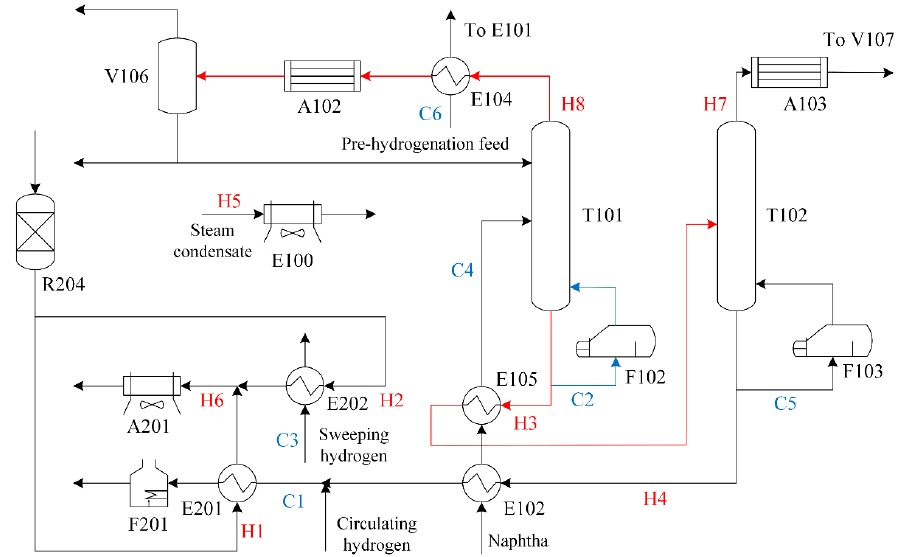
Figure 6. Partial flowsheet of the continuous reforming process.